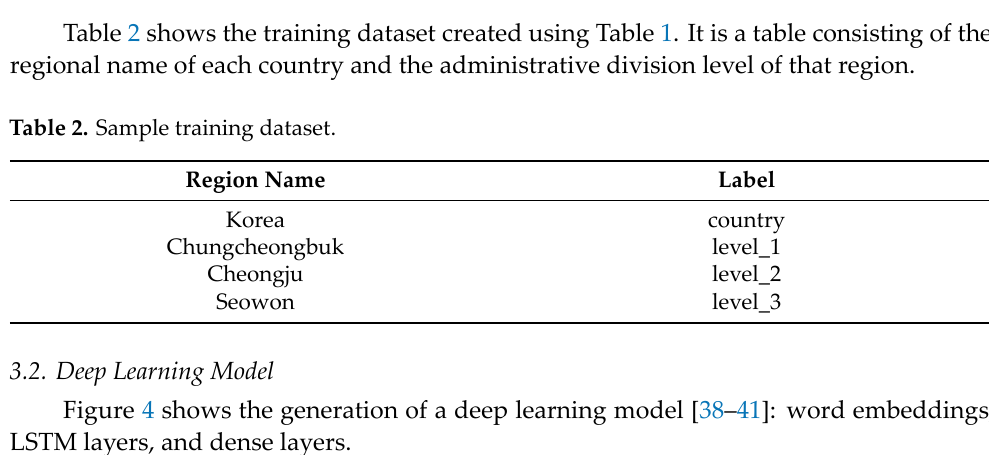
Figure 3. Proposed methodology flow.